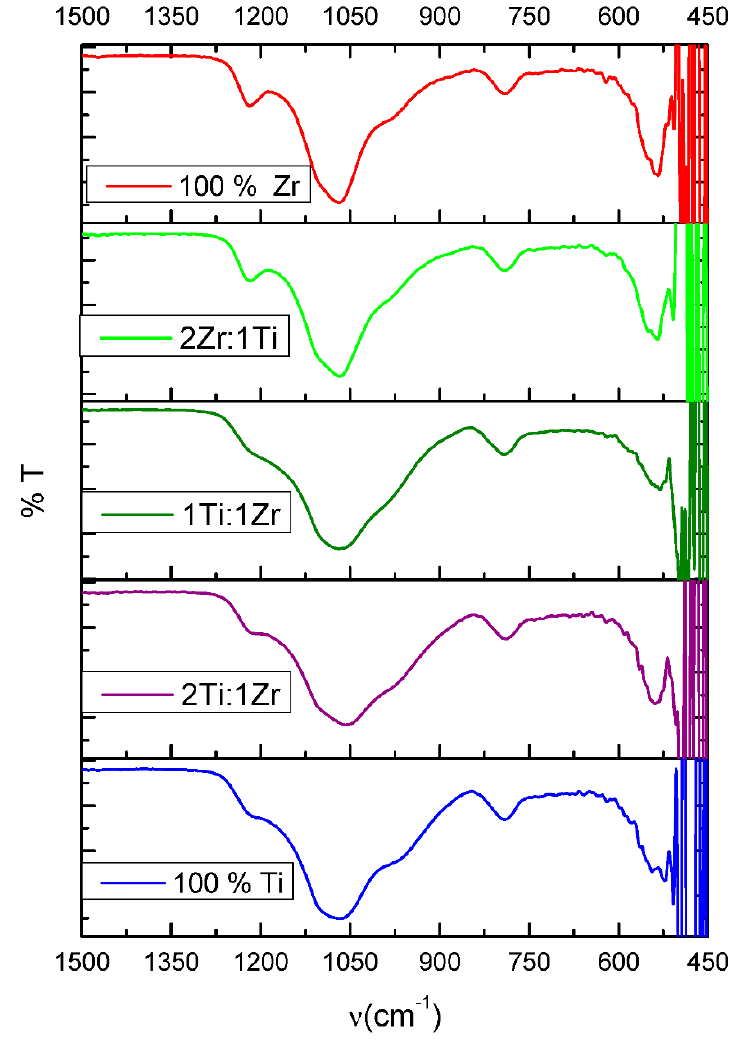
Figure 5. Infrared spectra of all investigated